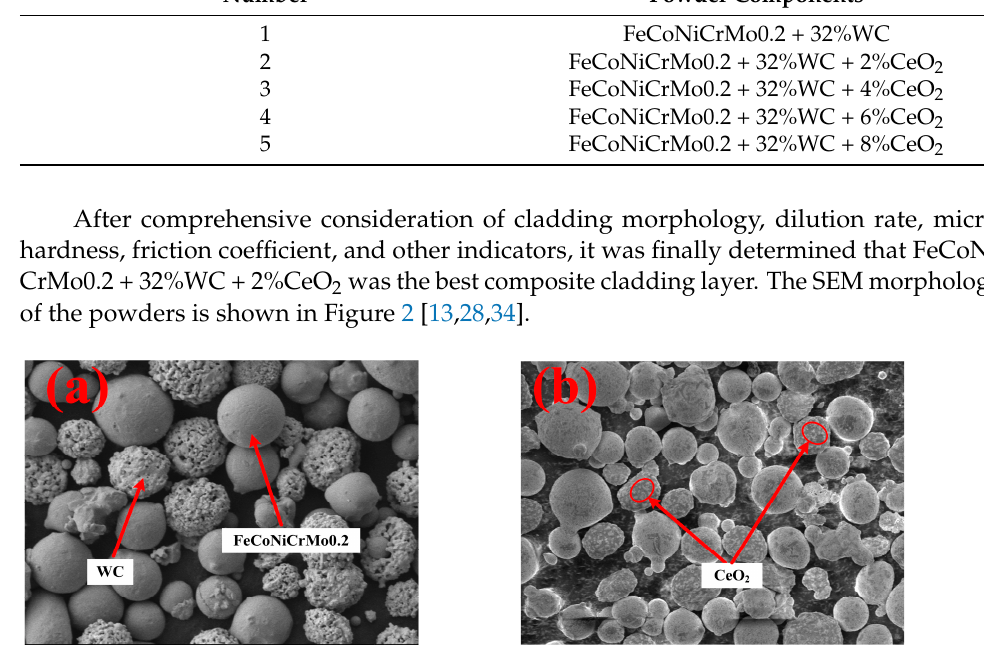
Figure 1. Laser cladding systems and equipment: ( a ) laser cladding equipment; ( b ) component modules of the fusion cladding system. Table 3. Chemical composition of CeO 2 composite powder with different contents.